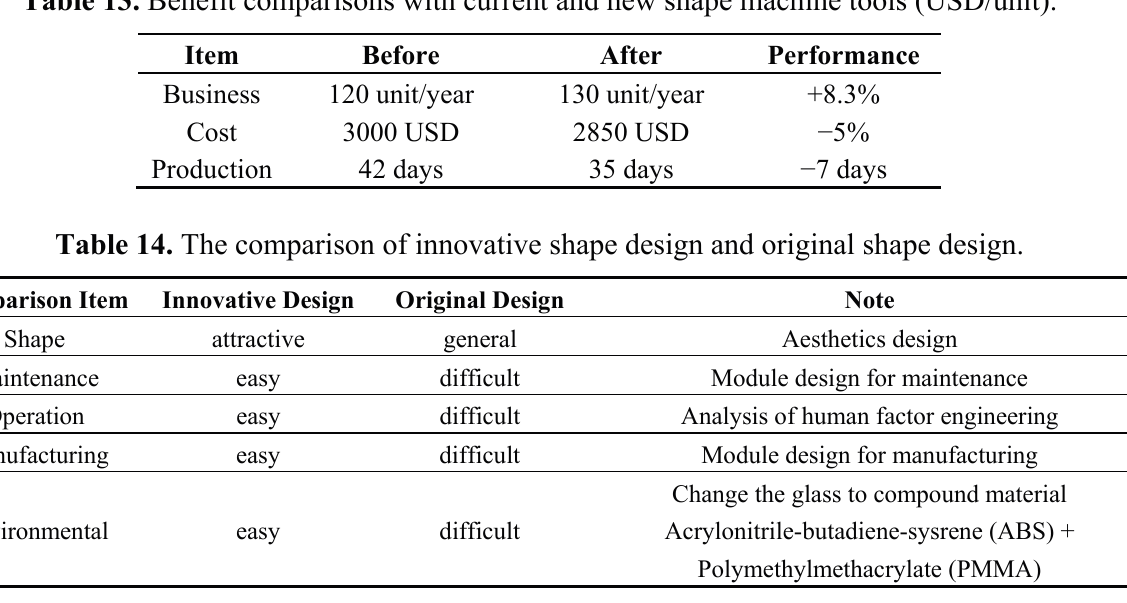
Table 13. Benefit comparisons with current and new shape machine tools (USD/unit).